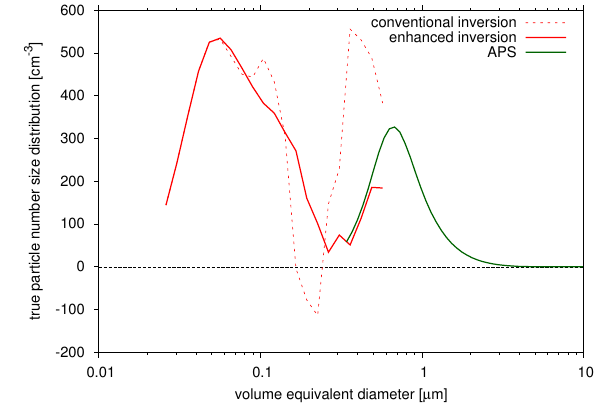
Fig. 3b. Results of the particle number size distribution (PNSD) obtained from multiple-charge inversion with different degrees of (PNSD) obtained from multiple charge inversion with differ- functionality. Solid green line: aerodynamic particle size distribu- ent degrees of functionality. Solid green line: aerodynamic tion (APS). Red dashed line: multiple-charge inversion using only particle size distribution (APS). Red dashed line: multiple SMPS data. Red solid line: enhanced multiple-charge inversion combining APS and SMPS charge inversion using only SMPS data. Red solid line: en- hanced multiple charge inversion combining APS and SMPS data.